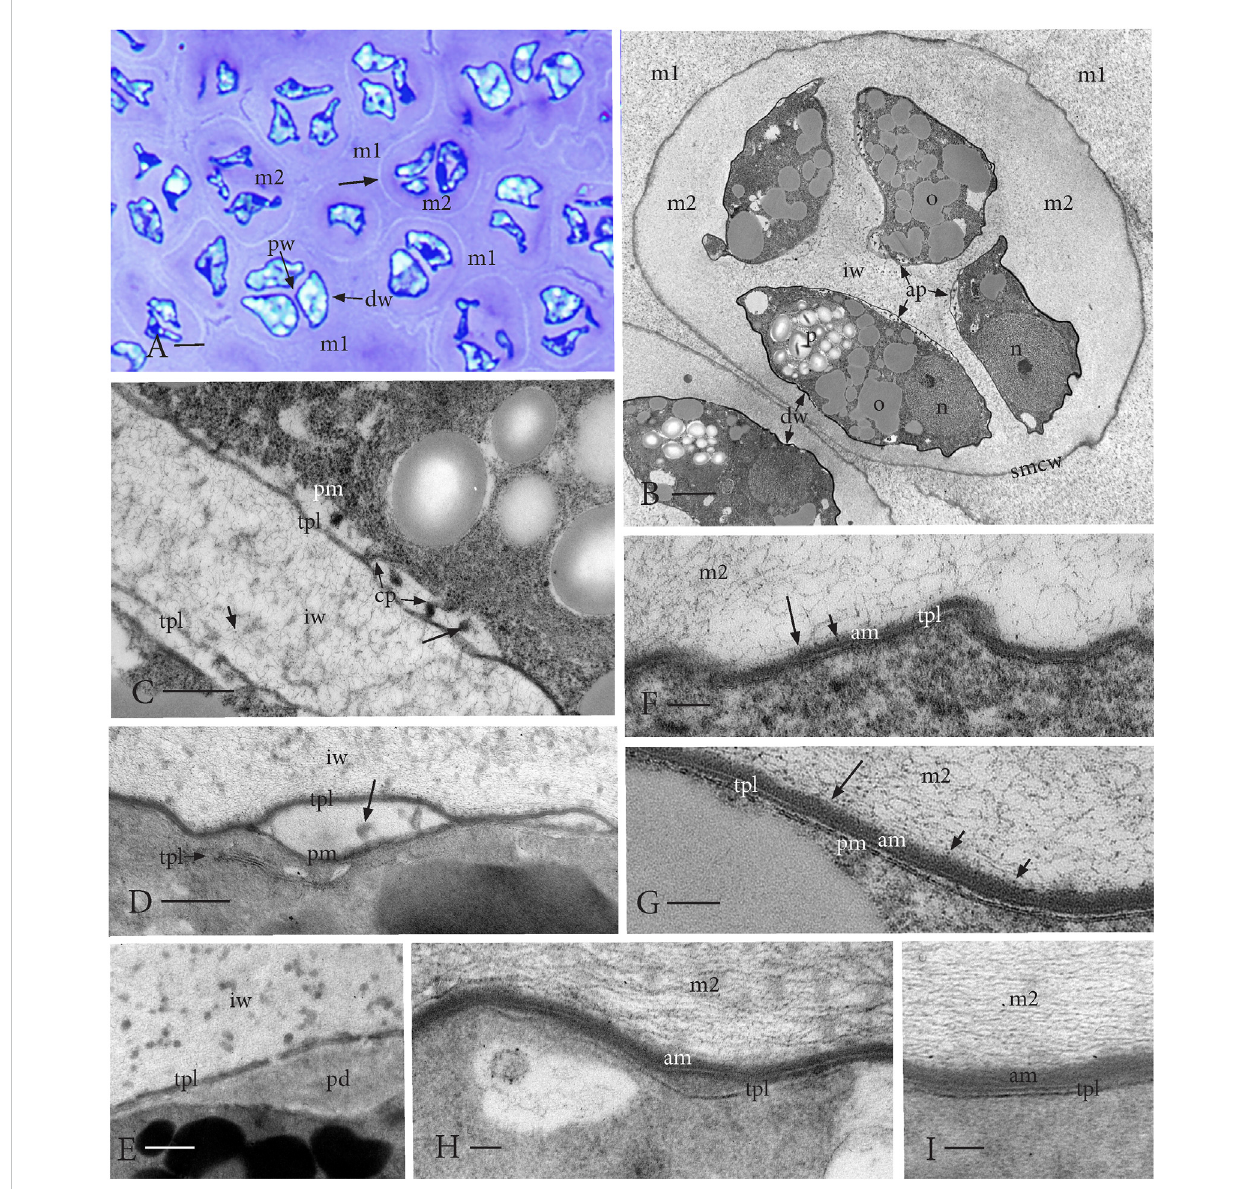
FIGURE 3 Nascentsporesintetradsinafullyexpandedcapsule. (A) LMofthenewlyformedtetradsembeddedinthelocularmatrix(m1)derivedprimarilyfrom the capsule tissue. The extraprotoplasmic matrix (m2) inside a thin SMC wall (arrow) surrounds the distal side (dw) of spores that are wavy in outline. An intersporal matrix separates spores in each tetrad along the proximal spore walls (pw). (B) TEM of nascent spores in a tetrad enclosed in the SMC wall (smcw) and embedded in the locular matrix (m1). Aperture (ap) formation is visible along proximal walls of spores where an intersporal matrix/wall (iw) separates spores. Wavy thin distal spore walls (dw) have occasional breaks. Dense spores contain a nucleus (n), starch- fi lled plastid (p), and abundant oil (o). (C) TEM of aperture initiation along the proximal wall in two adjacent spores showing regions of a loose fi brillar material with cytoplasmic projections (cp) and dense amorphous strands (long arrow) between the plasmalemma (pm) and single peripheral tripartite lamella (TPL). The intersporal matrix (iw) contains irregular fi bril inclusions and dots (short arrow). (D) TEM of layers of TPL in the spore cytoplasm near the developing aperture delimited by a single TPL and plasmalemma (pm) with inclusions (arrow). Fibrillar intersporal wall (iw) contains a scattered dense material. (E) TEM of the developing granular pad (pd) in the center of aperture covered by an interrupted TPL layer. Fibrous intersporal wall (iw) with scattered small dense globules. (F − I) Initiation and early development of the wavy distal spore wall. (F, G) TEMs of single TPL deposited from the spore cytoplasm, while fi brous (long arrow) and dotted (short arrow)material from the extraprotoplasmic matrix surrounding the tetrad (m2) accumulates on the spore outside forming anamorphouslayer(am). (H,I) AdditionalTPLfromthesporeisaddedtoformatwo-layeredlamellaonthedistalsurface.Amorphouslayer(am)thickens, and the extraprotoplasmic matrix (m2) contains faint dense globules. Scale bars: (A) = 5.0 μ m; (B) = 2.0 μ m; (C − E) = 0.5 μ m; and (F − I) = 0.1 μ